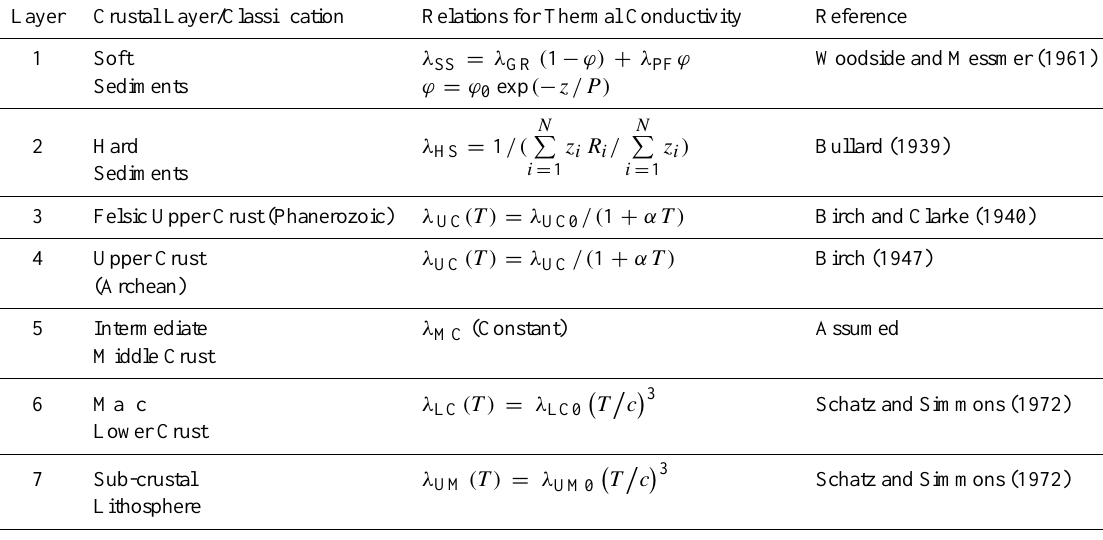
Table 3. Summary of the relations employed in specifying thermal conductivity ( λ) values for the system of layers constituting the structure of the